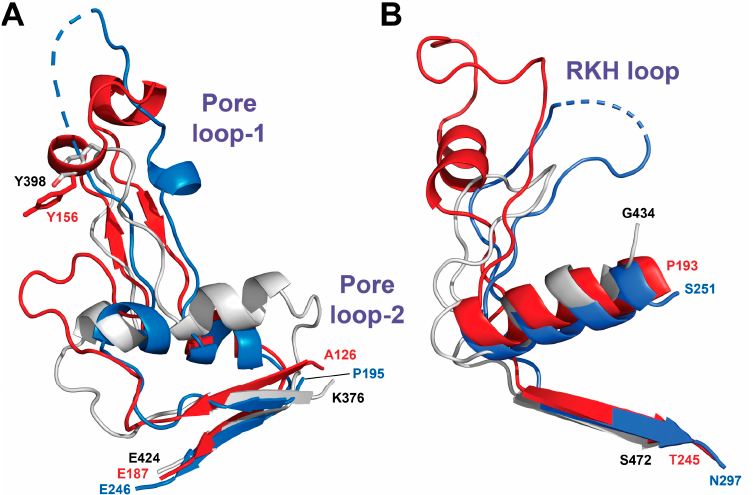
Figure 11. Superposition of three different Pore loops in various Lon subfamilies. Pore loop-1 ( A ) and RKH loop ( B ) are longer in both Bs LonBA (red) and Ton LonB (blue) than the corresponding loops in Ec LonA (white), while Pore loop-2 ( A ) is longer in the latter. Dashed lines indicate fragments that are not modeled in the experimental structures due to the lack of electron density. While in enzymes belonging to all Lon subfamilies the insertion of Pore loop-1 breaks a single helical fragment into two small helices ( α 4 and α 5; but in the model of LonBA α 4